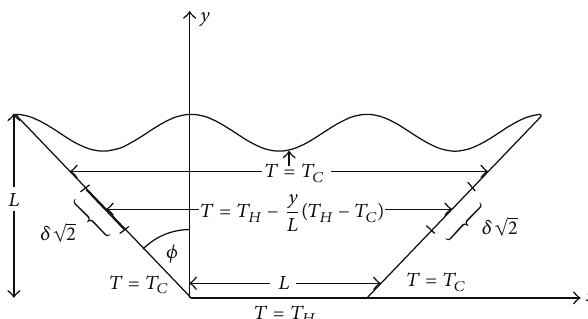
Figure 1: Physical model and boundary conditions of the enclosure with top wavy